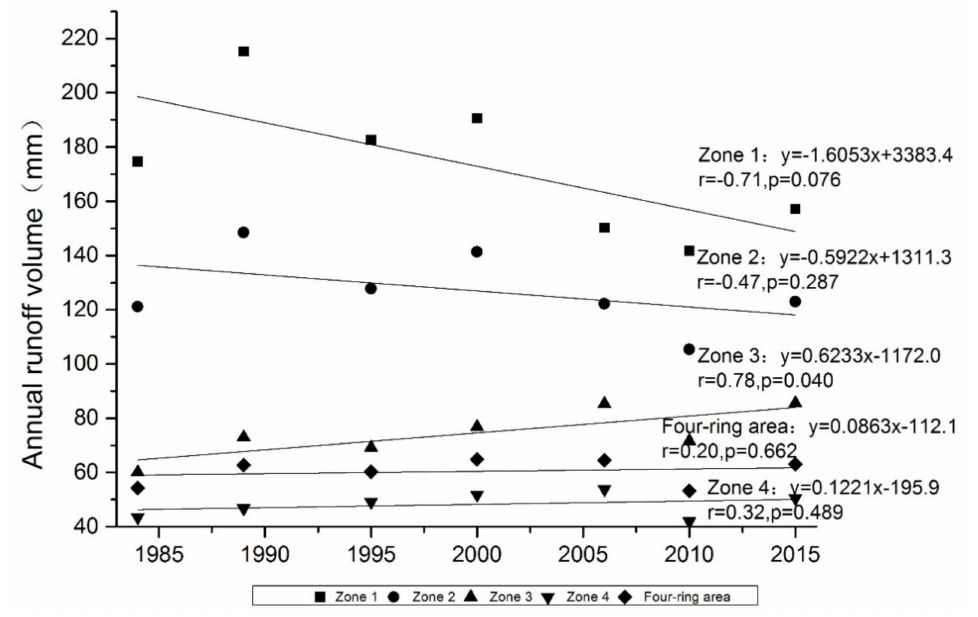
Figure 3. Trends of direct runoff at regional